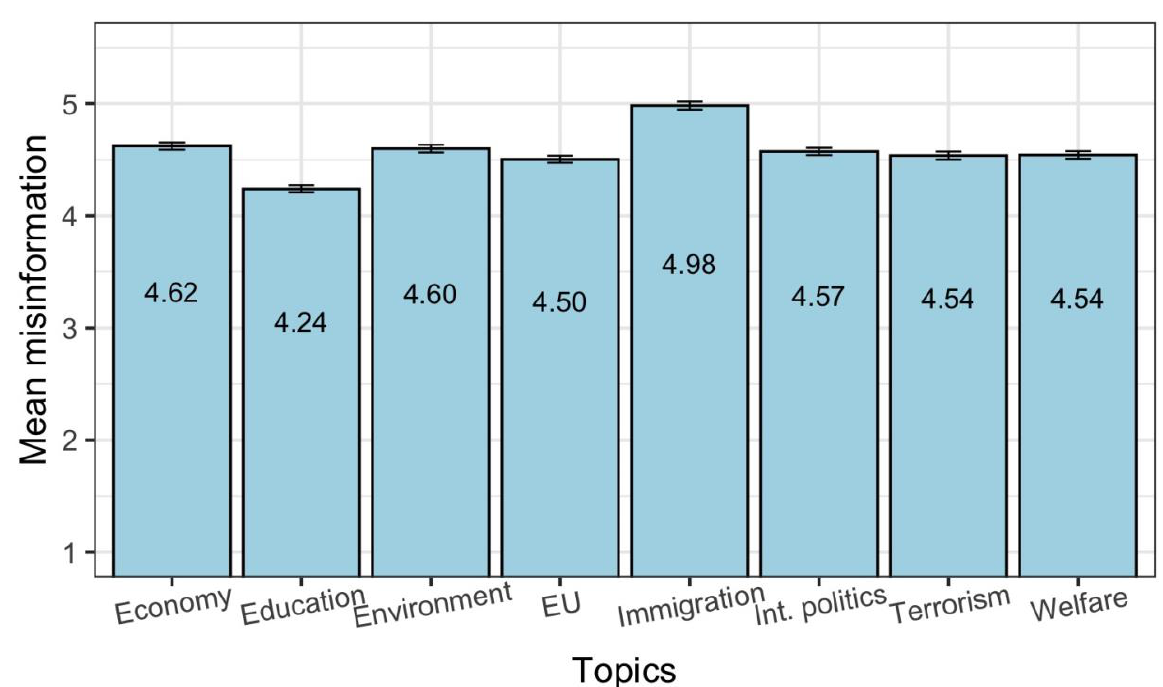
Figure 2. The topics associated most with misinformation. All perceptions are measured on 7-point scales (1= no inaccurate or dishonest information on this topic at all, 7 = very much inaccurate or dishonest information on the